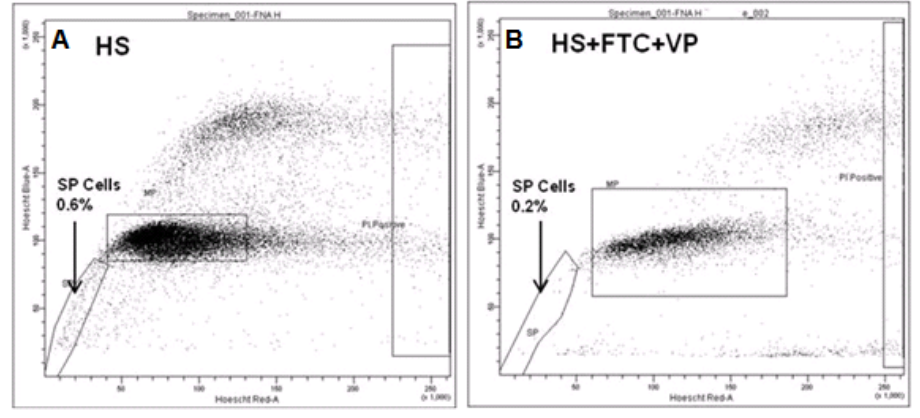
Figure 1. SP profile for a fine needle aspirate taken from a male breast cancer patient. ( A ). A SP population of 0.6% of the total cell population was observed when cells were incubated with 2.5 µg/mL Hoechst 33342 dye; ( B ). The efflux of Hoechst dye by the SP population was partially inhibited by addition of a combination of 10 µM FTC and 50 µM verapamil prior to the Hoechst incubation. * Prior to Hoechst staining samples were lysed twice with Red Blood Cells (RBC) lysis buffer and propidium iodide was added prior to flow cytometry analysis to exclude non-viable